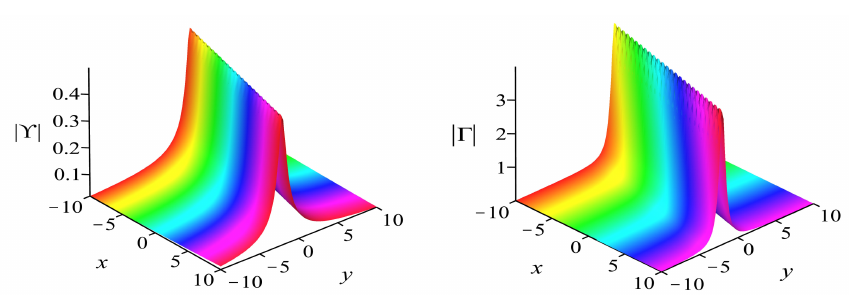
Figure 4. The evolution of solution (56) with α = 0.5, β = γ = 2, ν = λ = η = p = 1, ω = σ = − 2, s 2 = i , z = − 0.5, and t =